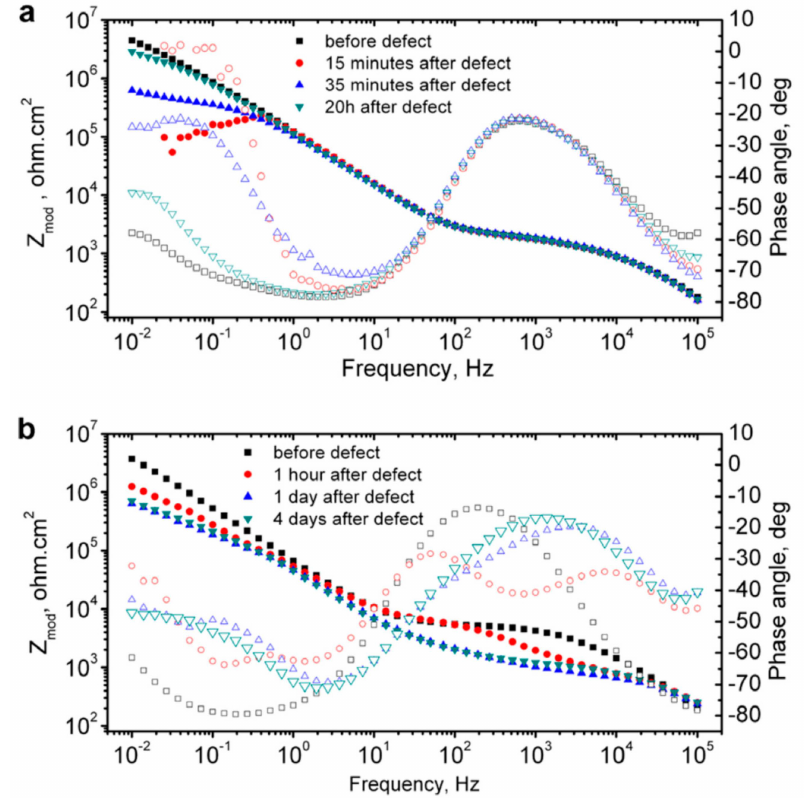
Figure 9. EIS plots of ( a ) inhibitor doped double-layer sol-gel film and ( b ) undoped single-layer sol–gel film during immersion in 0.5 NaCl. Adapted from [64], with permission from © 2007